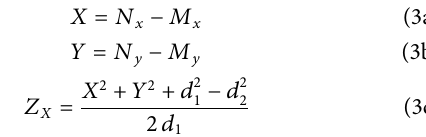
Frontiers in Robotics and AI |